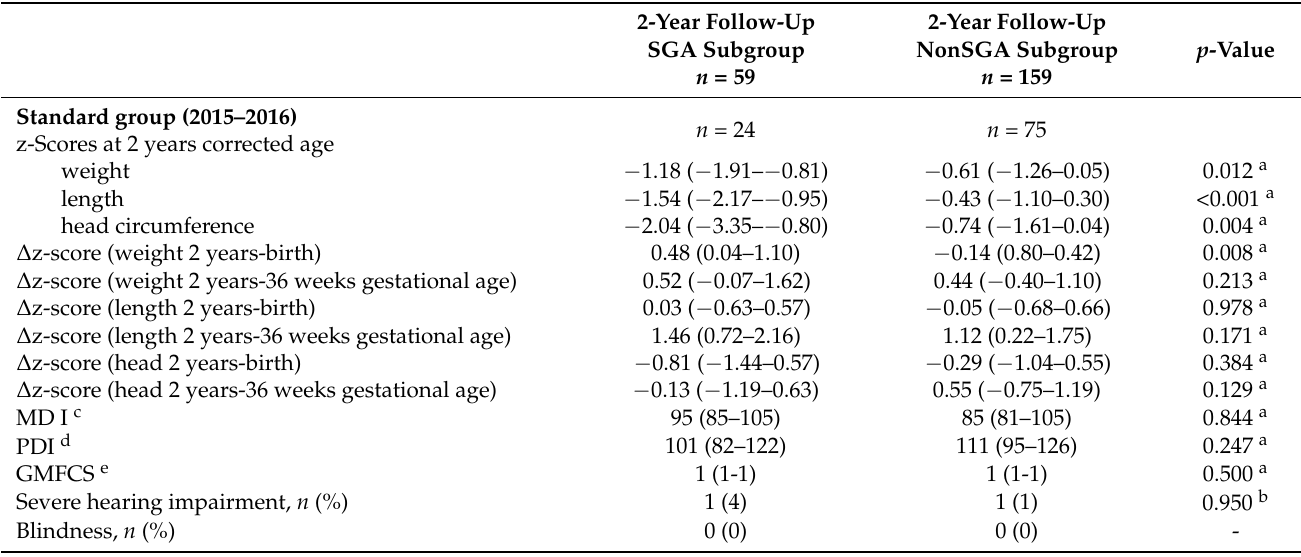
Table 4. 2-year somatic and psychomotor outcome variables in the study collective—SGA vs. nonSGA